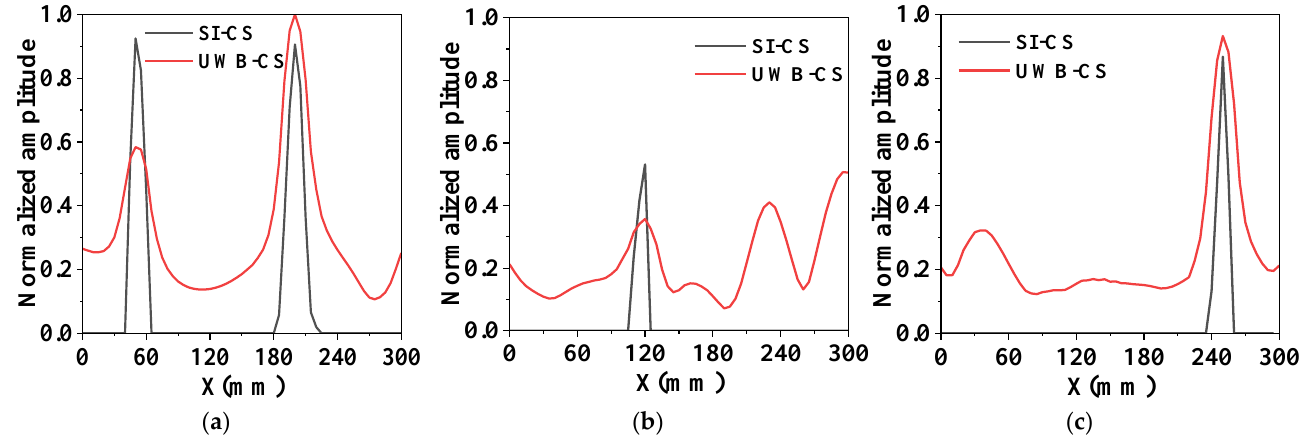
Figure 16. The trend of the peak in the lateral direction at the PIM source location for the UWB-CS method and the SI-CS method; ( a ) the first and second PIM sources; ( b ) the third PIM source; ( c ) the fourth PIM source.